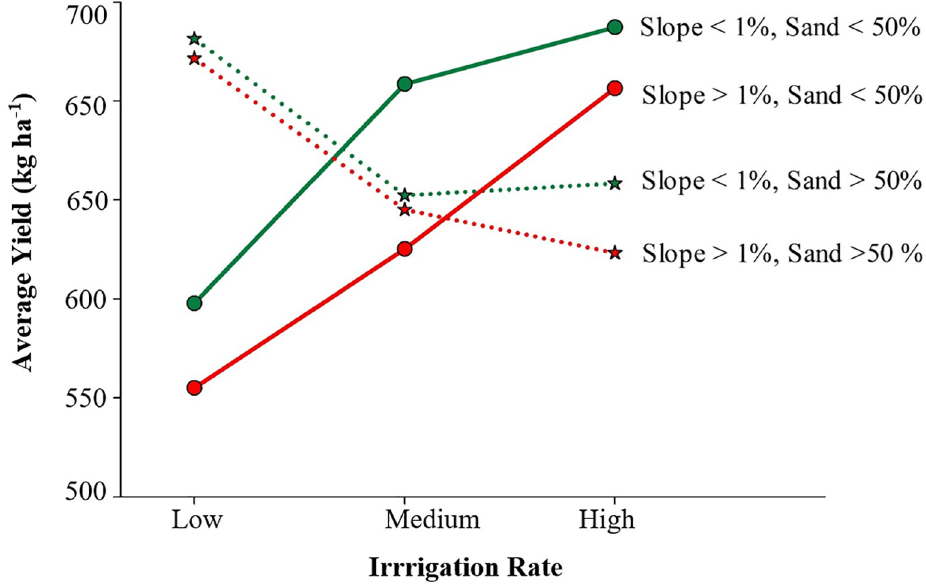
Fig 9. Interaction effects between irrigation rates, sand content (0–15 cm), and slope on cotton yield in a 72-ha field in Hale County, Texas in 2017.